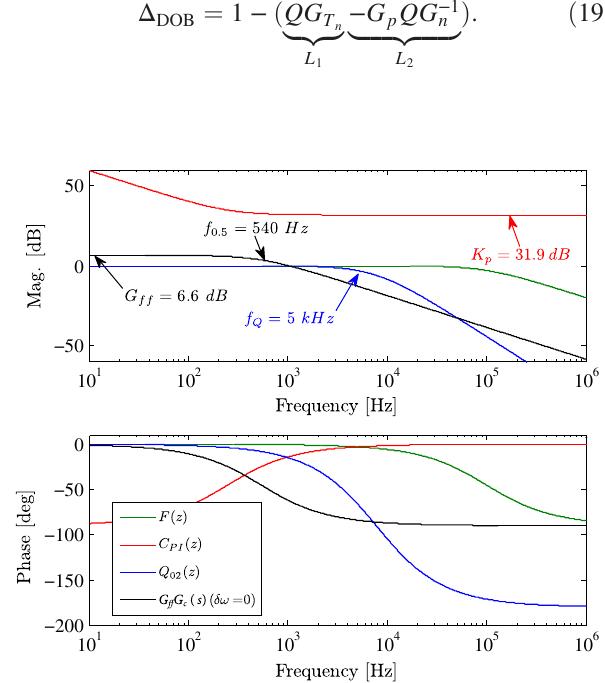
ð z Þ , Q ð z Þ and G ð s Þ . G 02 PI ff c